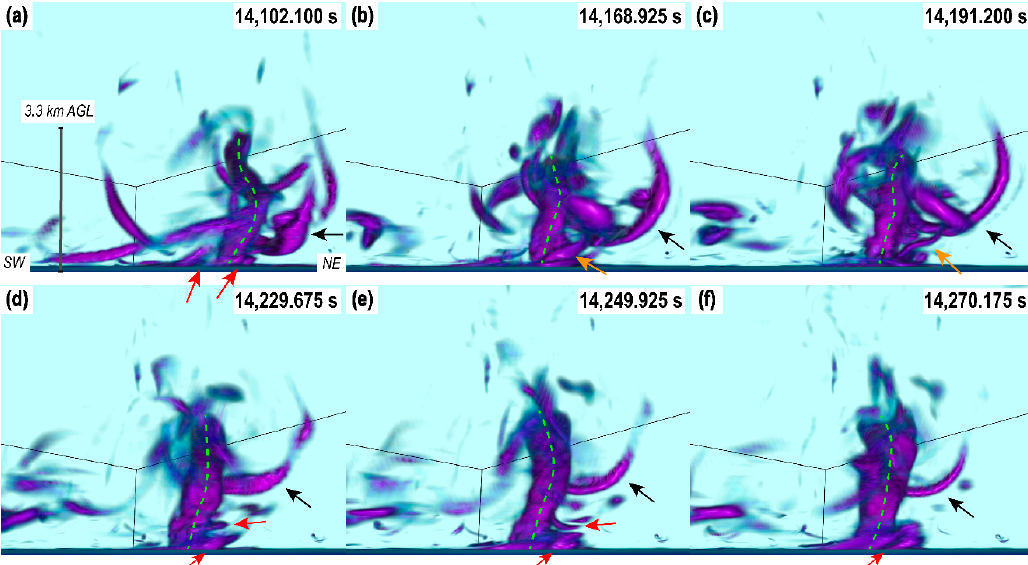
Figure 5. DVR of vorticity magnitude, highlighting values greater than 0.15 s − 1 , at select time frames: ( a ) 14,102.100 s, ( b ) 14,168.925 s, ( c ) 14,191.200 s, ( d ) 14,229.675 s, ( e ) 14,249.925 s, and ( f ) 14,270.175 s. The view point is that of an observer located at the southeast corner of the domain, looking toward the northwest corner. The green dashed line denotes the tornado vortex axis. Red arrows indicate vortices that form around the tornado and surrounding RFD outflow at the surface. Orange and black arrows indicate distinct vortices used for comparison with real vortices in Figure